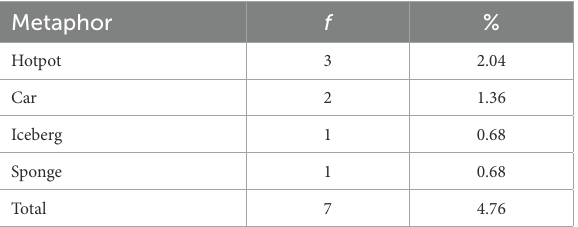
TABLE 4 Frequency and percentage of the textbook metaphor in the conceptual category of “curiosity.” Metaphor f